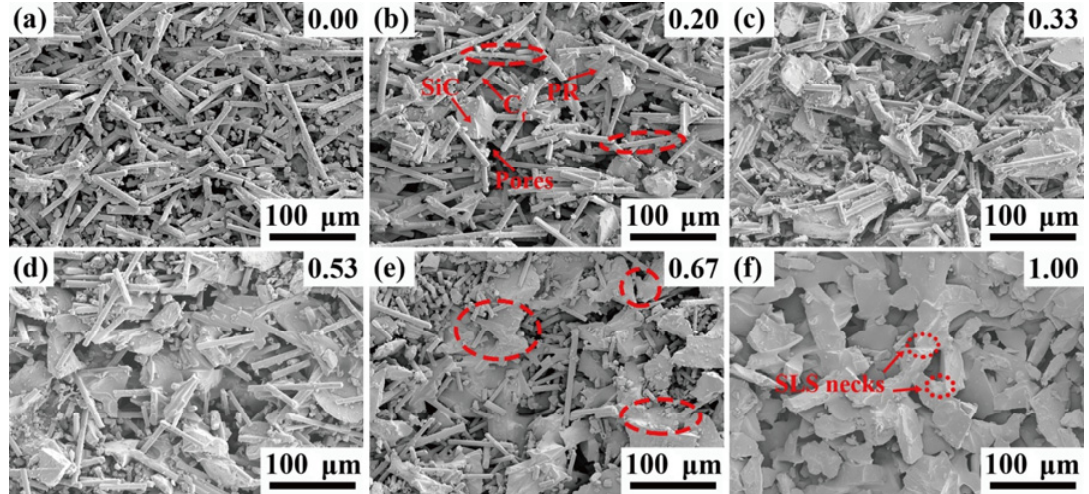
Fig. 5 Morphologies of C f /SiC/PR printed bodies with different SiC contents: (a) SiC:IM = 0; (b) SiC:IM = 0.20; (c) SiC:IM = 0.33; (d) SiC:IM = 0.53; (e) SiC:IM = 0.67; and (f) SiC:IM = 1.